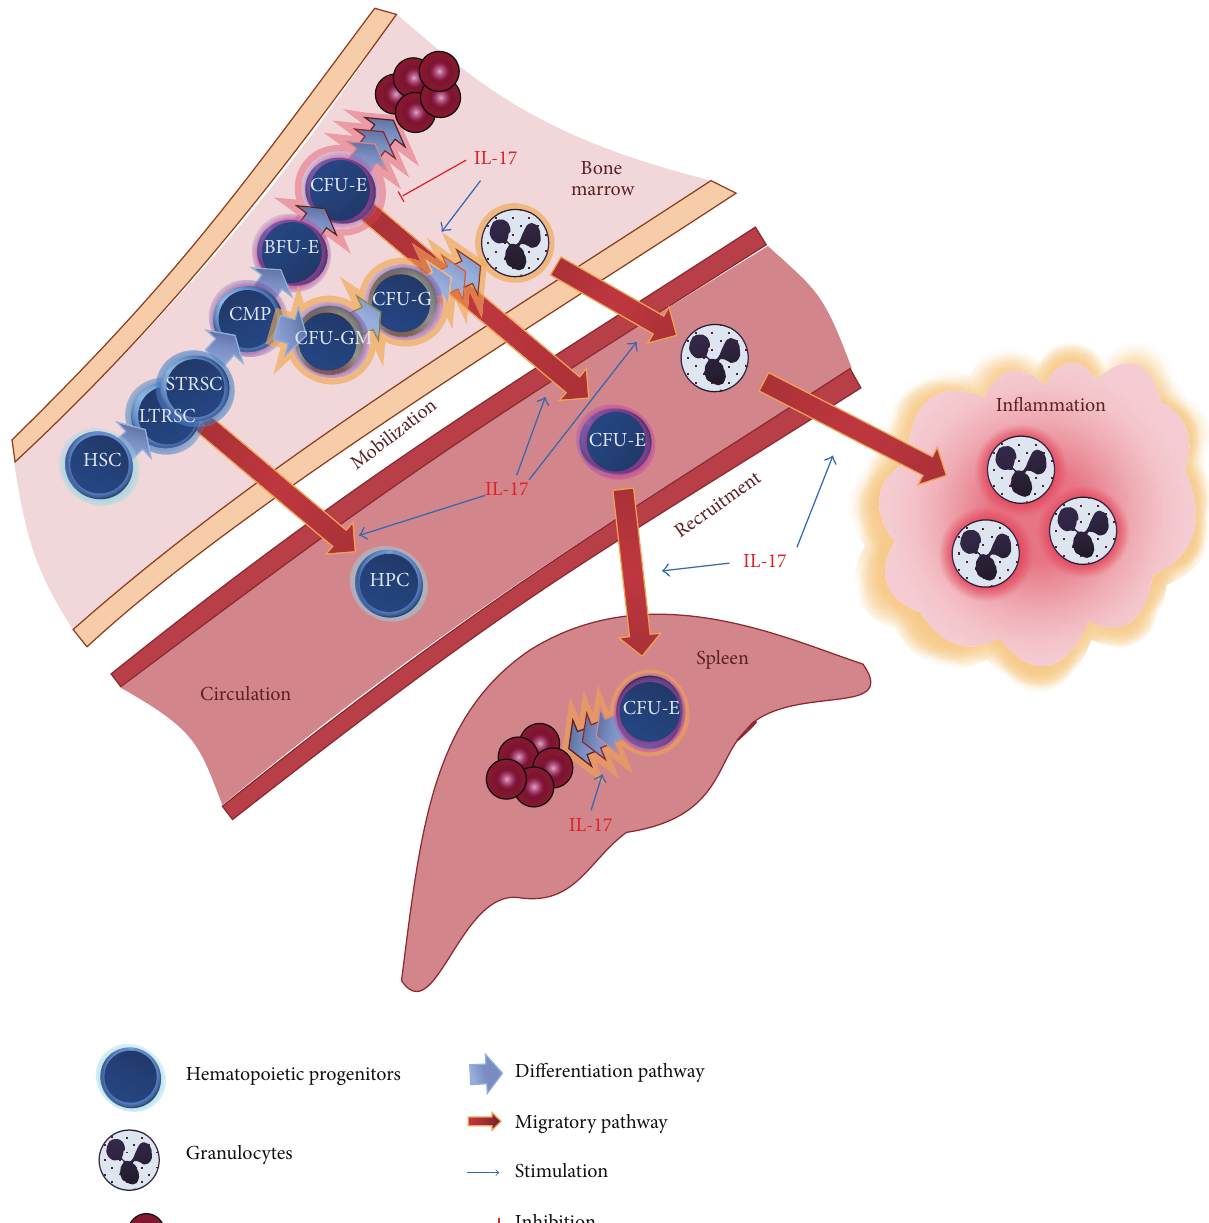
Figure 1: Effects of IL-17 on hematopoietic cells. In bone marrow, IL-17 stimulates granulopoiesis and downregulates erythropoiesis through inhibitionoflatestageerythroidprogenitors,CFU-E.Atthesametime,IL-17stimulatesmobilizationofhematopoieticprogenitorsandmature granulocytes into circulation. Through secondarily induced chemotactic factors, IL-17 stimulates recruitment of granulocytes into a site of inflammation. It also stimulates erythropoiesis in spleen, by mobilizing erythroid progenitors from bone marrow to spleen and stimulating splenic CFU-E differentiation. HSC: hematopoietic stem cell; HPC: hematopoietic progenitor cell; LTRSC: long-term repopulating stem cell; STRSC: short-term repopulating stem cell; CMP: common myeloid progenitor; CFU-GM: colony-forming unit-granulocytic-monocytic; CFU-G: colony-forming unit-granulocytic; BFU-E: burst-forming unit-erythroid; CFU-E: colony-forming unit-erythroid.